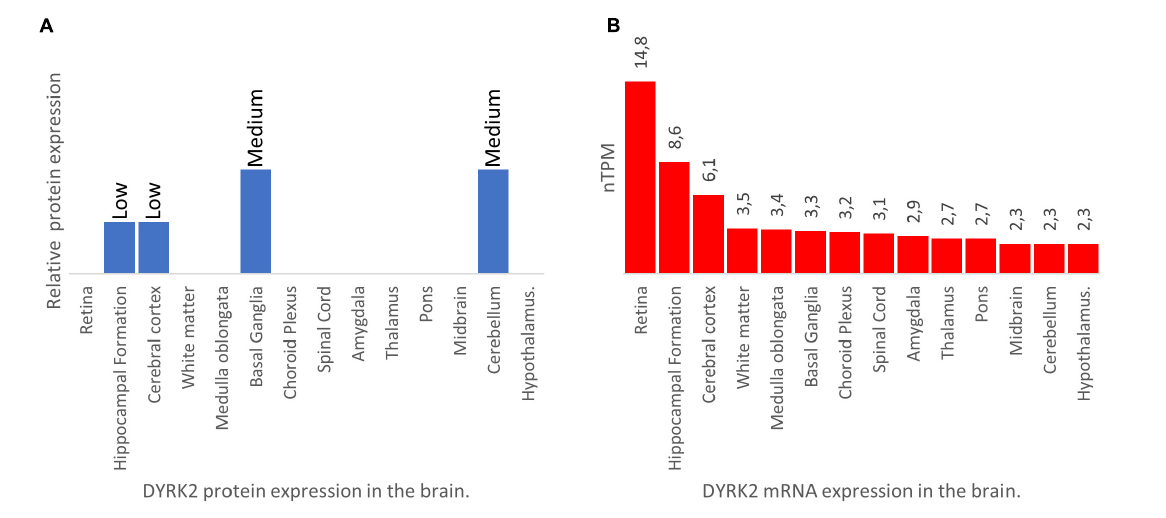
FIGURE1 DYRK2 mRNA and protein brain distribution according to the Human Protein Atlas (https://www.proteinatlas.org/). (A) DYRK2 protein data from fluorescent immunohistochemistry experiments. The data corresponds to the “protein expression dataset.” Units represent relative fluorescence to the maximum fluorescence found across all the tissues probed (neural and non-neural). (B) DYRK2 mRNA data from RNA-seq experiments. The data corresponds to the “consensus dataset.” Units are expressed as number of transcripts per million